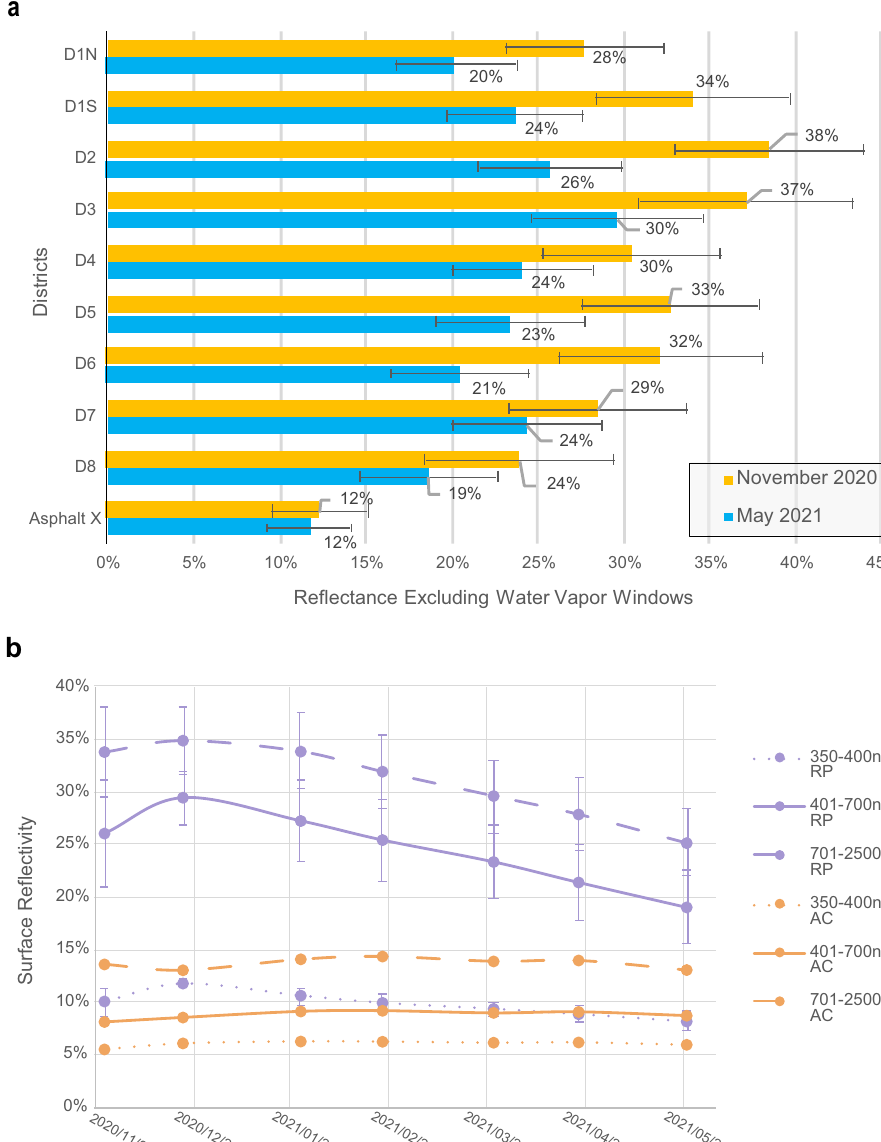
400 – 700nm), and dashed line — near infrared (NIR; 700 – 2500nm). RP data represents averages for all 8 Districts, and error bars represent the standard deviation. Source data are provided as a Source Data fi le. a and b are modi fi ed for colors and readability, with permission, from Figures 11b and 12 of the Cool Pave- ment Pilot Program reportby Middel et al. (2021) publishedunder a CC